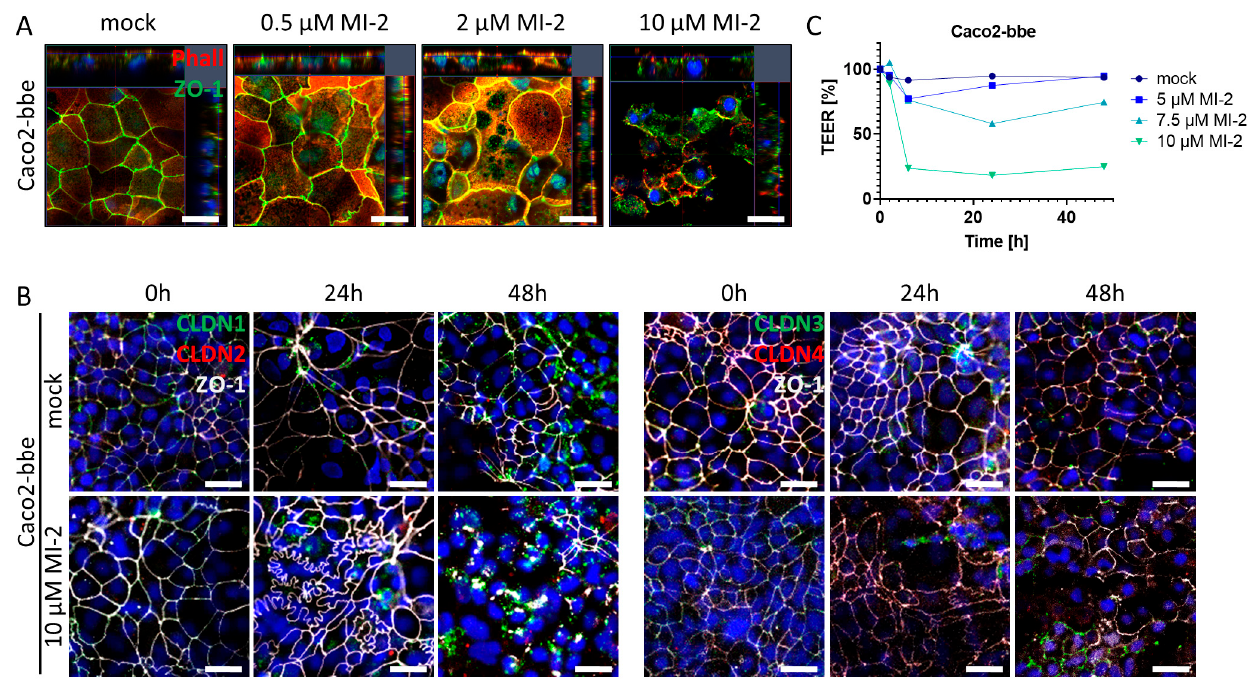
Figure 5. MALT1 proteolytic activity supports epithelial tight junctions. ( A ) Representative images of Caco2-bbe cell monolayers stimulated with indicated MI-2 concentrations 48 h after stimulation immunocytochemically stained with antibody against ZO-1 (green) and phalloidin-594 dye (Phall, red), nuclei were counterstained with Hoechst 33342 (blue) (scale bar: 50 µ m). ( B ) Representative images of 10 µ M MI-2 stimulated Caco2-bbe cell monolayers over time. Monolayers were immunocytochem- ically stained with antibodies against ZO-1 (white) and in the left panel claudin-1 (green), claudin-2 (red) and in the right panel claudin-3 (green), claudin-4 (red), nuclei were counterstained with Hoechst 33342 (blue) (scale bar: 50 µ m). ( C ) TEER measurement of MI-2 stimulated Caco2-bbe